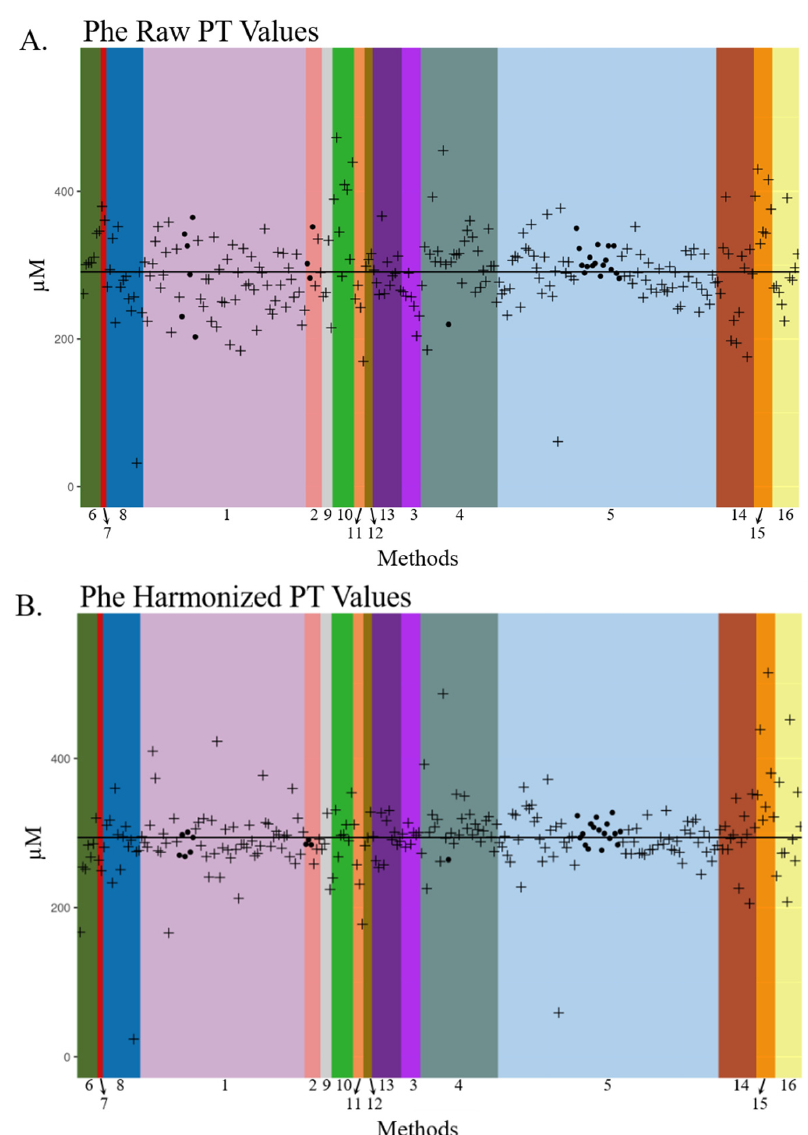
Figure 4. Dot plot of phenylalanine proficiency test raw and harmonized data across participating newborn screening labs from 2019. Dot plots of raw ( A , B ) harmonized phenylalanine (Phe) proficiency test (PT) data reported by US public health and international NBS laboratories in 2019. Laboratory names are de-identified. Laboratory PT values are grouped by analytical method, and these unique methods are denoted by color and number. Each “•” indicates a unique US public health laboratory’s PT concentration and each “ + ” indicates a unique US non-public health or international laboratory’s PT concentration for Phe. The black solid lines represent the mean of PT values in each plot. Method 1: Derivatized—MS/MS LDT; Method 2: PerkinElmer NeoGram AAAC Tandem Mass Spectrometry kit (Waltham, MA, USA); Method 3: Perkin Elmer Neobase TM 2 Non-derivatized MSMS kit (Waltham, MA, USA); Method 4: Non-derivatized - MS / MS LDT; Method 5: PerkinElmer NeoBase